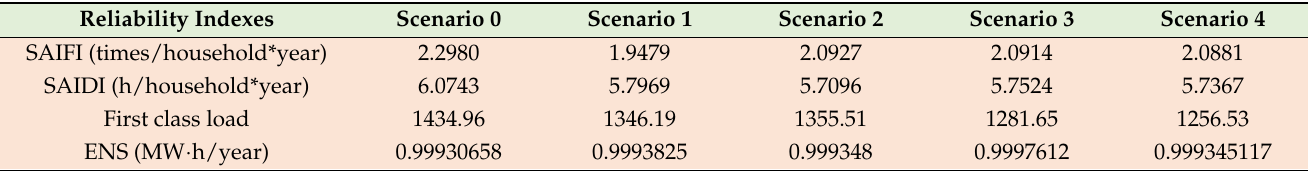
Table 3. Comparison of distribution system reliability indexes.